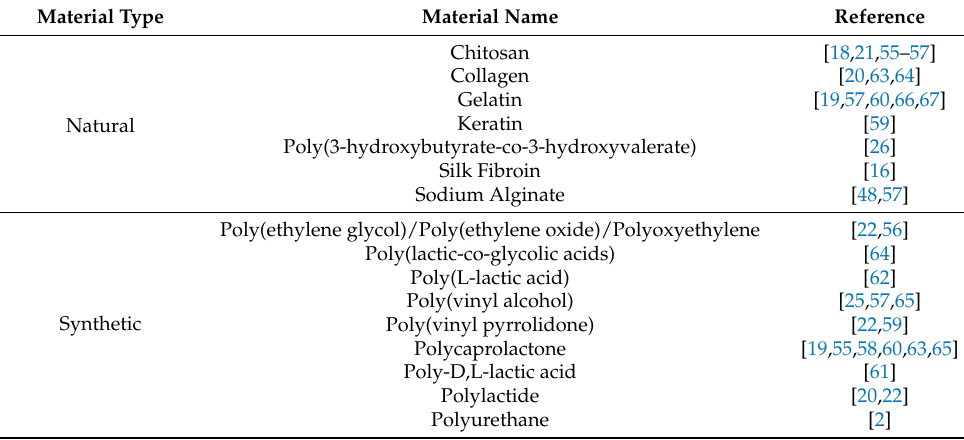
Table 3. Materials used for the production of electrospun fibers in 24 articles